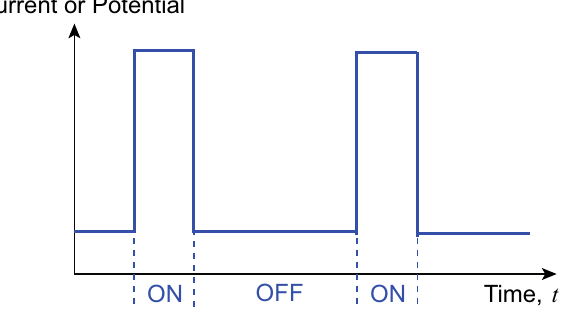
Fig. 5 Current or potential signals applied in pulse